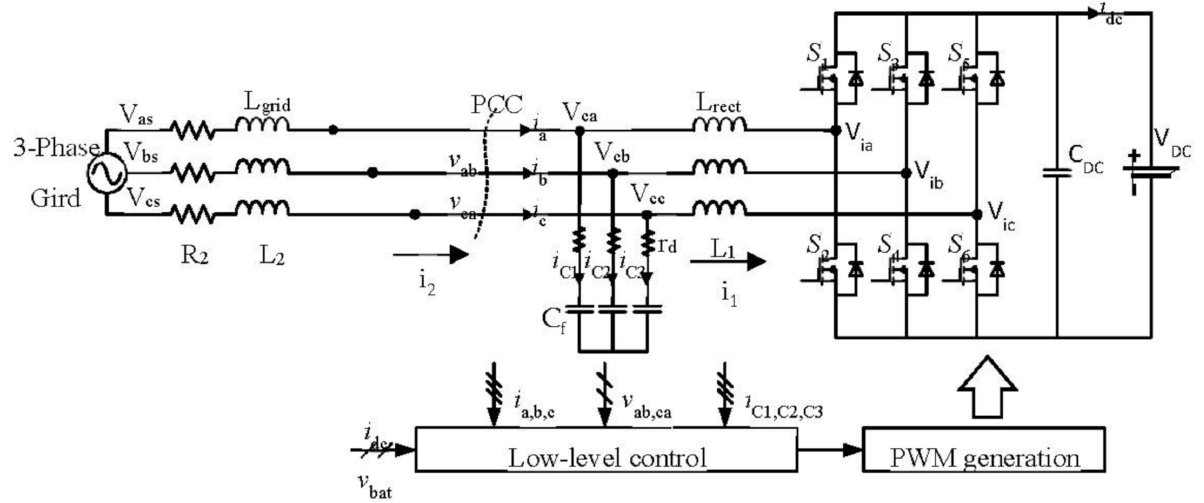
Figure 3. Circuit and control diagram of the SiC off-board